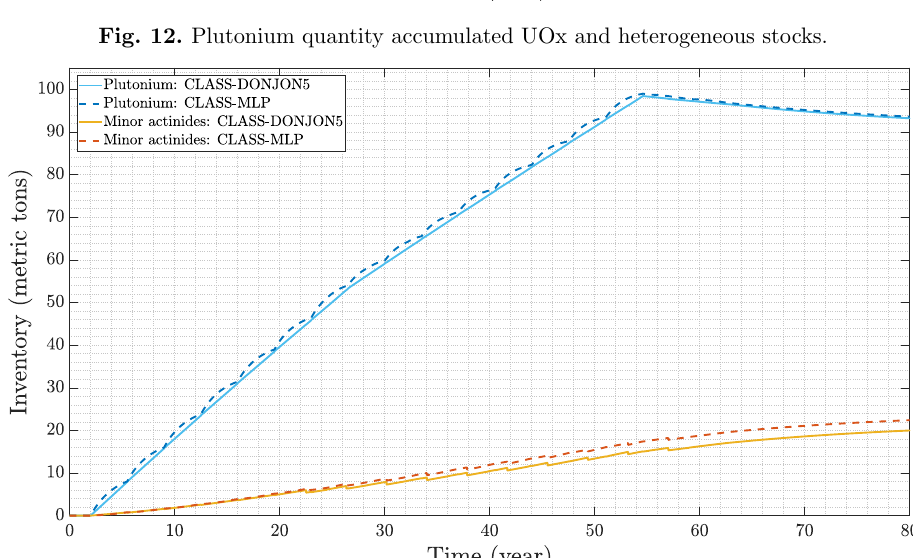
Fig. 13. Global plutonium and minor actinides inventories accumulated in-cycle. Table 13. Relative differences (%) for plutonium